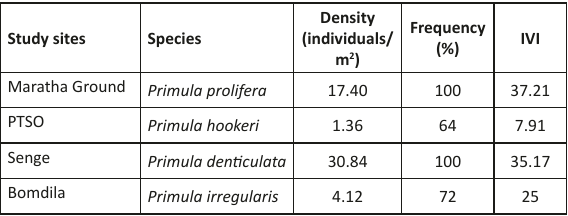
Table 5. Population status of Primula species recorded in their respective